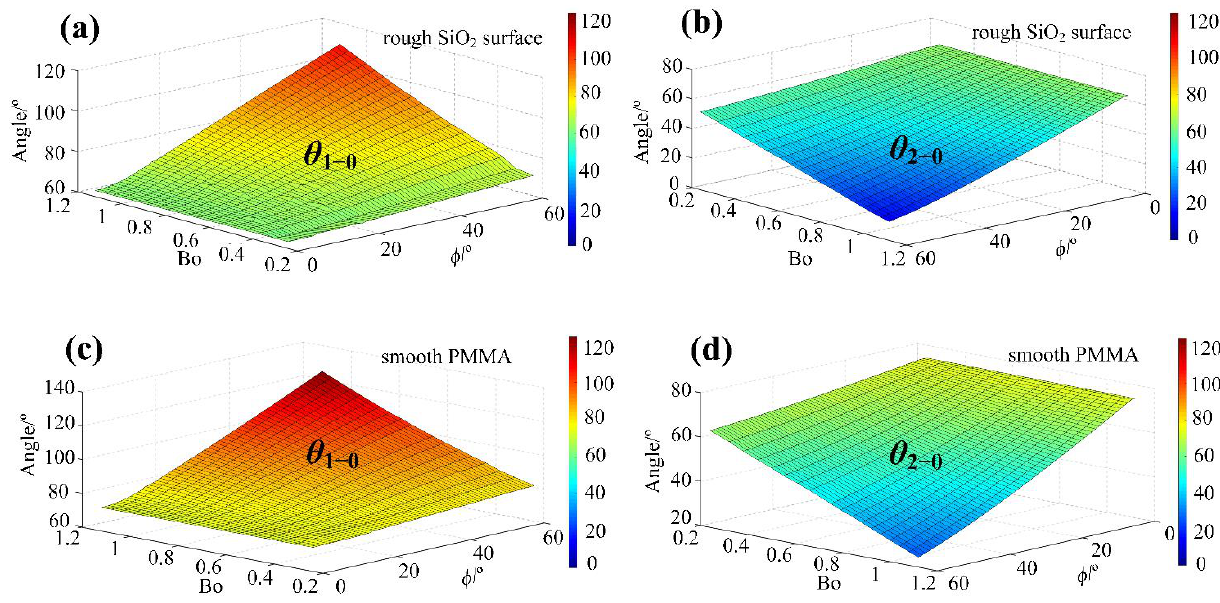
Figure 10. Changes of front contact angle θ 1 − 0 and rear contact angle θ 2 − 0 with bond number Bo and tilt angle ϕ . ( a , b ) the SiO 2 rough surface ( d = 6 μm, h = 12 μm and a = 60 μm). ( c , d ) The smooth PMMA surface.